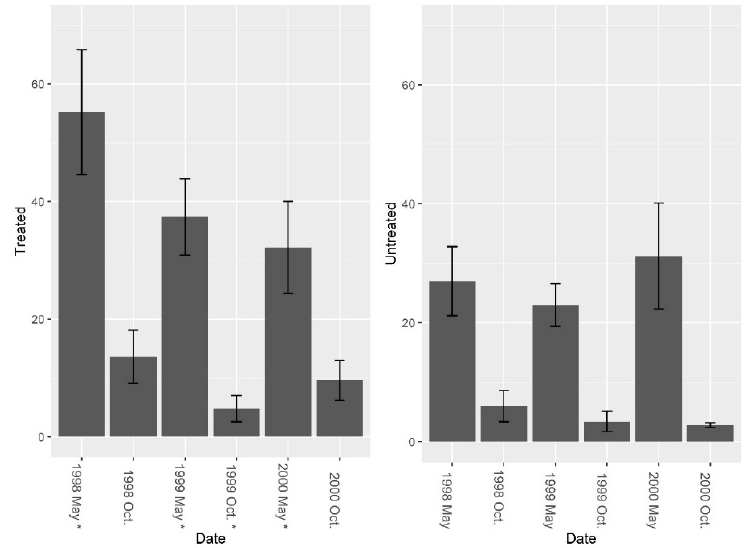
Figure 6. Mean (±1 SE) invertebrate abundance (excluding fire ants) collected from burrow vacuuming at five pairs of treated and untreated study sites at CSJFTC, 1998–2000. Pre ‐ treatment abundance of burrow invertebrates (excluding fire ants) was significantly different between sites (F = 14.14, df = 4, P = 0.019), and a nearly significant treatment effect was present (F 1, 7 = 4.01, P = 0.085). Asterisks on the x ‐ axis indicate when treatments occurred.